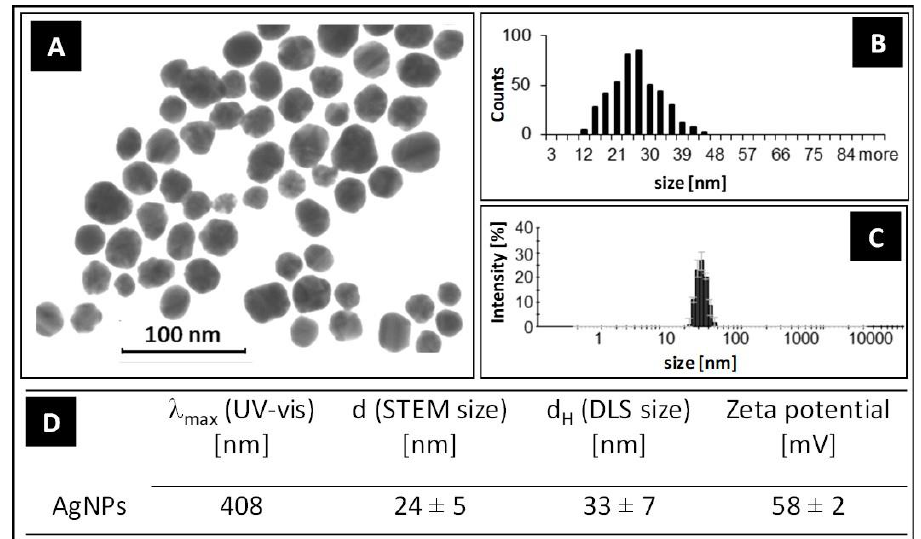
Figure 1. Scanning transmission electron microscopy (STEM) image of silver nanoparticles (AgNPs) ( A ), STEM size distribution histogram ( B ), dynamic light scattering (DLS) size distribution histogram ( C ), and the overall results of the AgNPs ’ characterization ( D ).